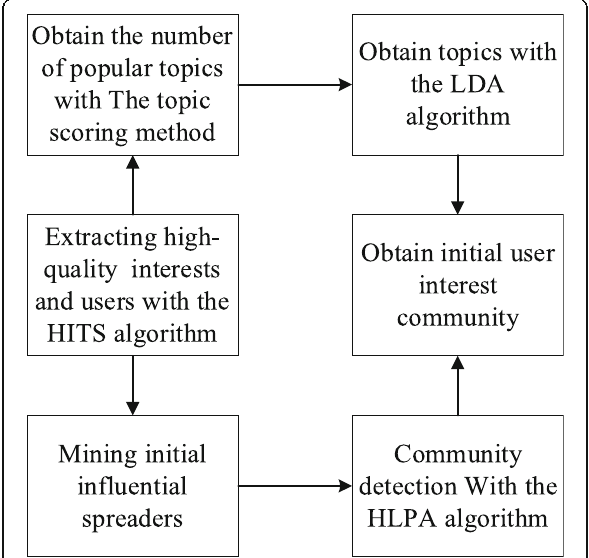
Fig. 1 The Procedure of the preprocessing